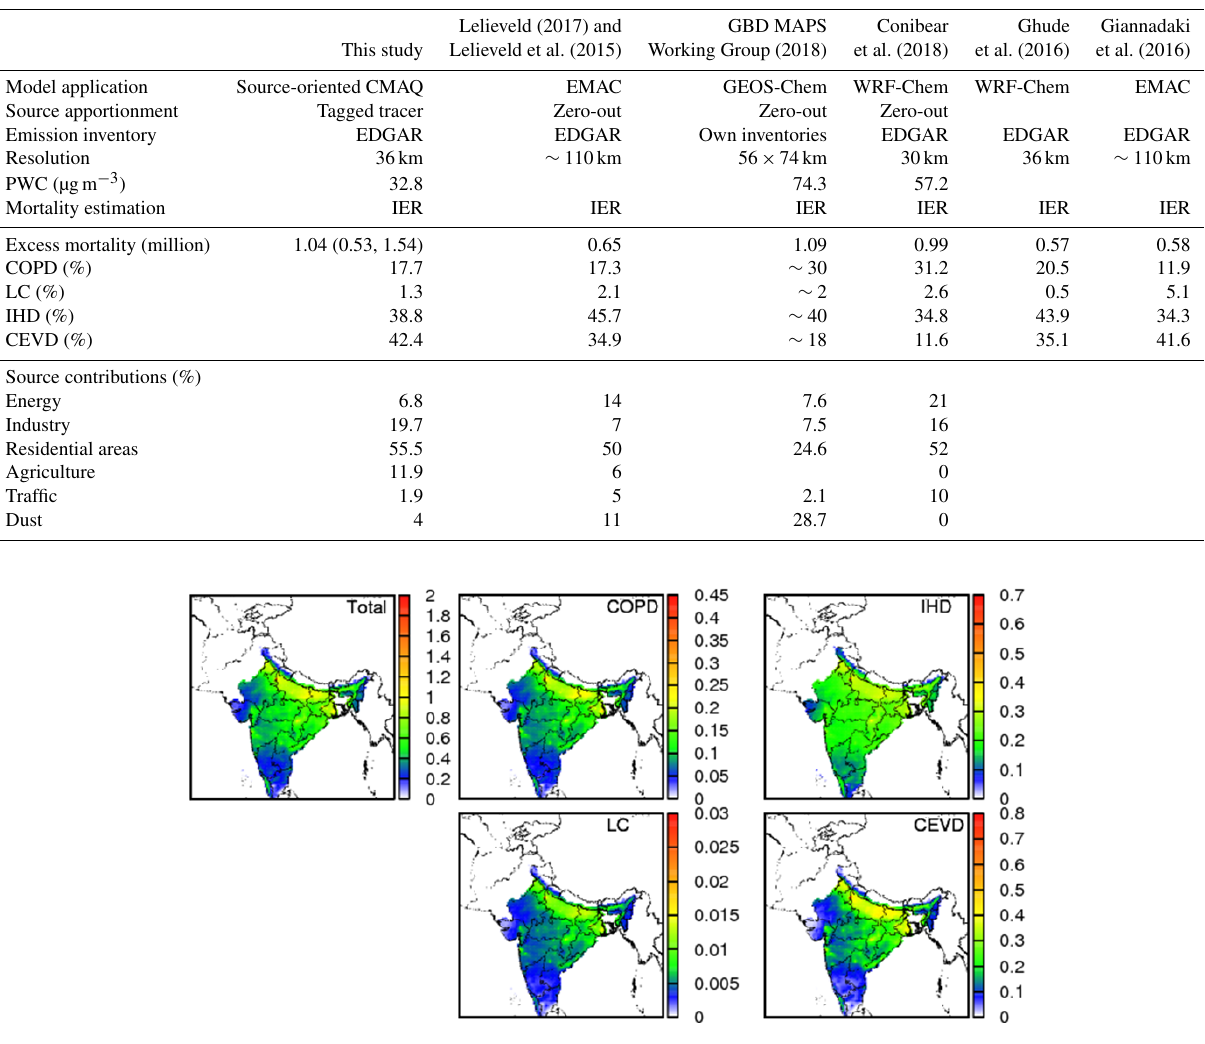
Figure 2. Years of life lost (YLL) based on population (years) due to COPD, LC, IHD, and